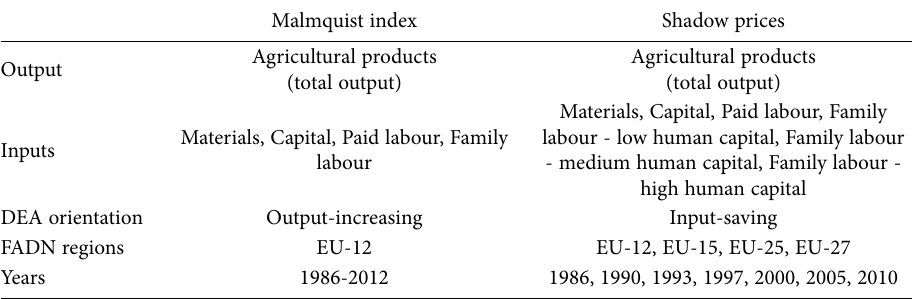
Table 3. DEA model